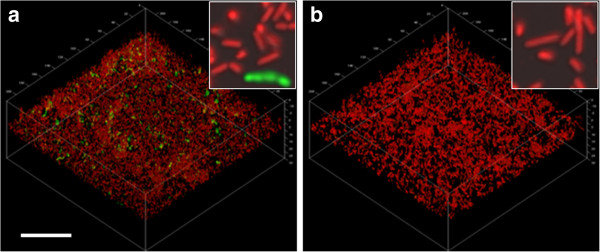
Proteolytic activities of Lactobacillus fermentum biofilm populations in the presence of (a) surface-associated or (b) fluid-phase MUC5B mucins. CSLM images showing biofilm cells growing in (a) the presence of a surface-coat of MUC5B mucins or (b) in the presence of MUC5B mucins in the fluid phase. Proteolytic activity was visualized by incubation with a FITC-conjugated casein substrate (green) for 1 hour. Cells were then counterstained using Syto 24 (red). The bar represents 20 μm and the inserts show four-fold enlargements of the main micrographs.